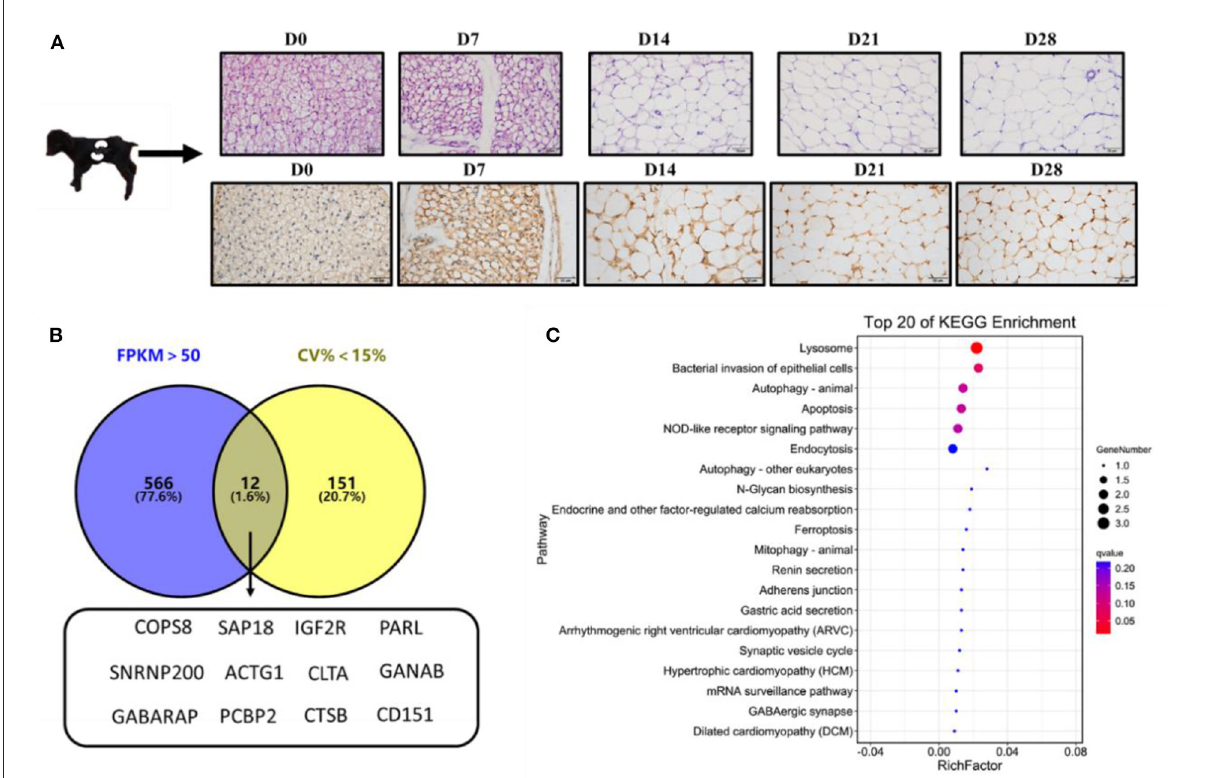
FIGURE1 Selection of novel candidate reference genes. (A) Hematoxylin-eosin (HE) and UCP1immunohistochemical staining of perirenal adipose tissue; (B) Venn diagram of overlapping genes with FPKM > 50 and CV < 15%; (C) The top 20 enriched signaling pathways of the 12 candidate reference genes based on KEGG analysis.